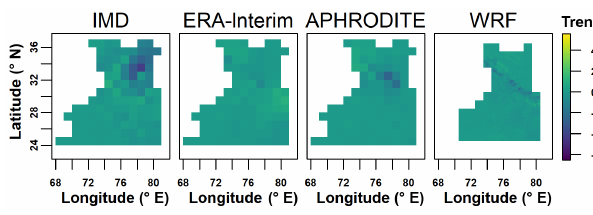
Figure 9. Trend (mmmonth − 1 year − 1 ) of winter precipitation.